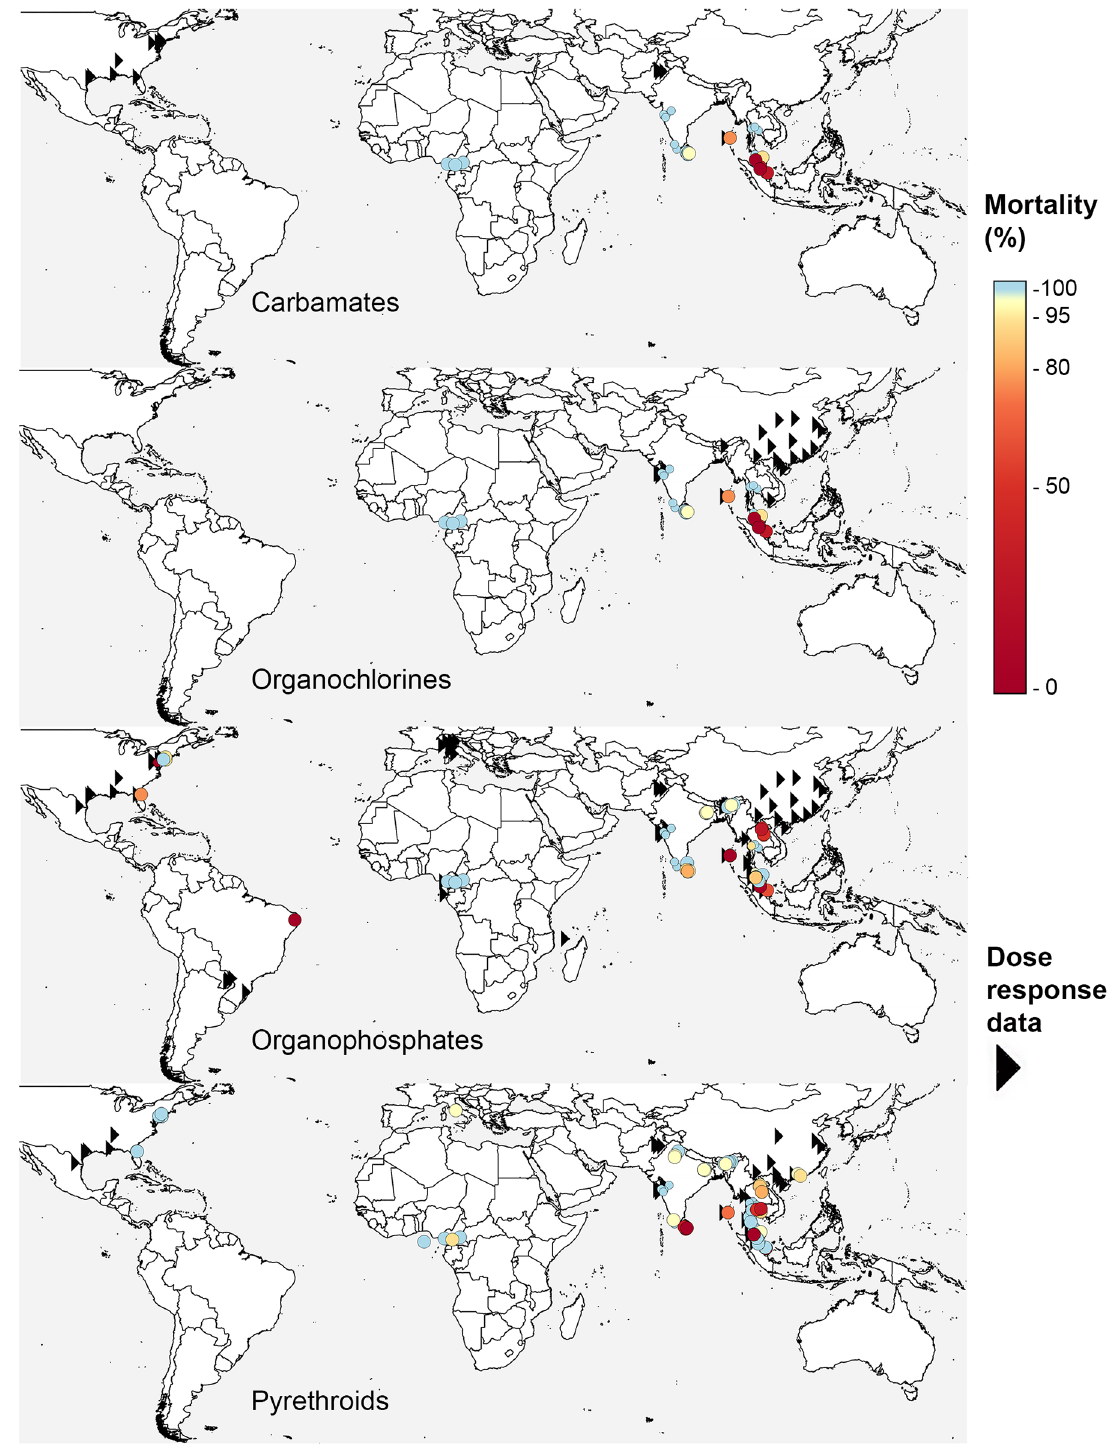
Fig 4. Frequency of insecticide resistance in Aedes albopictus in all years. The locationsof Ae . albopictus populations used in susceptibility(circles) and dose-response (triangles)bioassaysfor each of the 4 main classes of neurotoxicinsecticide. Both adult and larval bioassaysare included.Mortality values for 2006–2015are denotedby larger circles and the years up to 2005 are denotedby smaller circles.